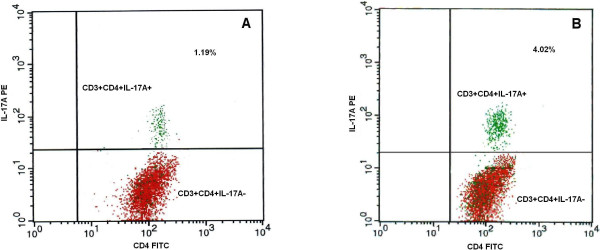
PMBCs isolated from controls and allergic rhinitis patients were stimulated with PMA and Brefeldin A for 5 hours followed by adding MAB FITS anti-human CD4 and anti-human CD3 PerCP. Production of IL-17 by PBMCs was determined at the single-cell level by intracellular cytokine staining and flow cytometric analysis. The upper right quadrants represent the percentage of IL-17 T cells with expression of CD3 and CD4 cells in the total lymphocyte populations gated. The dot plots show CD4 T cells producing IL-17 in human peripheral blood lymphocytes from healthy controls (A) and rhinitics (B).